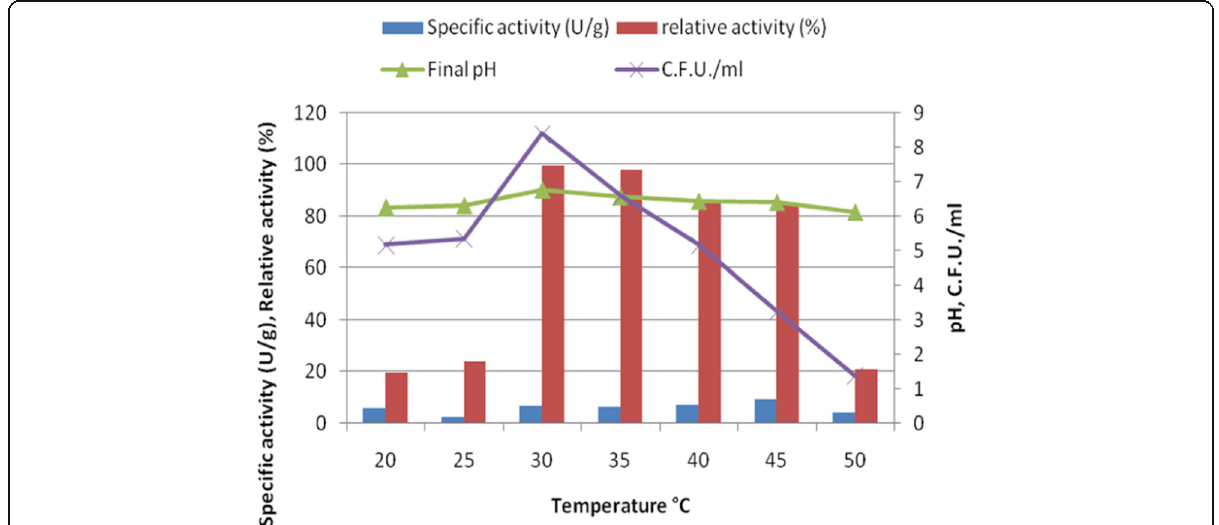
Fig. 3 Effect of different temperatures on specific and relative activities of chitinase produced by Stenotrophomonas maltophilia JF66